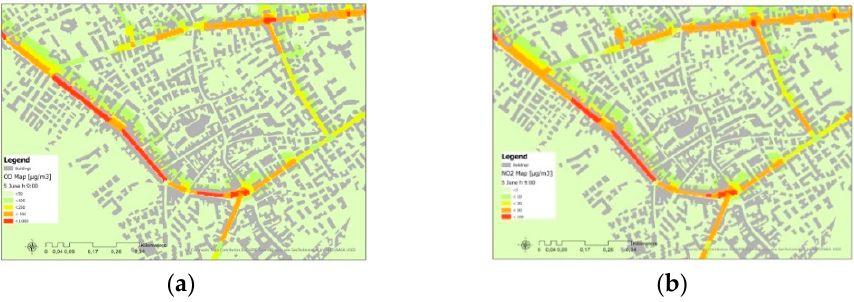
Figure A1. Maps of the estimated concentrations on 5 June at 9 a.m.: ( a ) CO concentrations; ( b ) NO 2 concentrations.